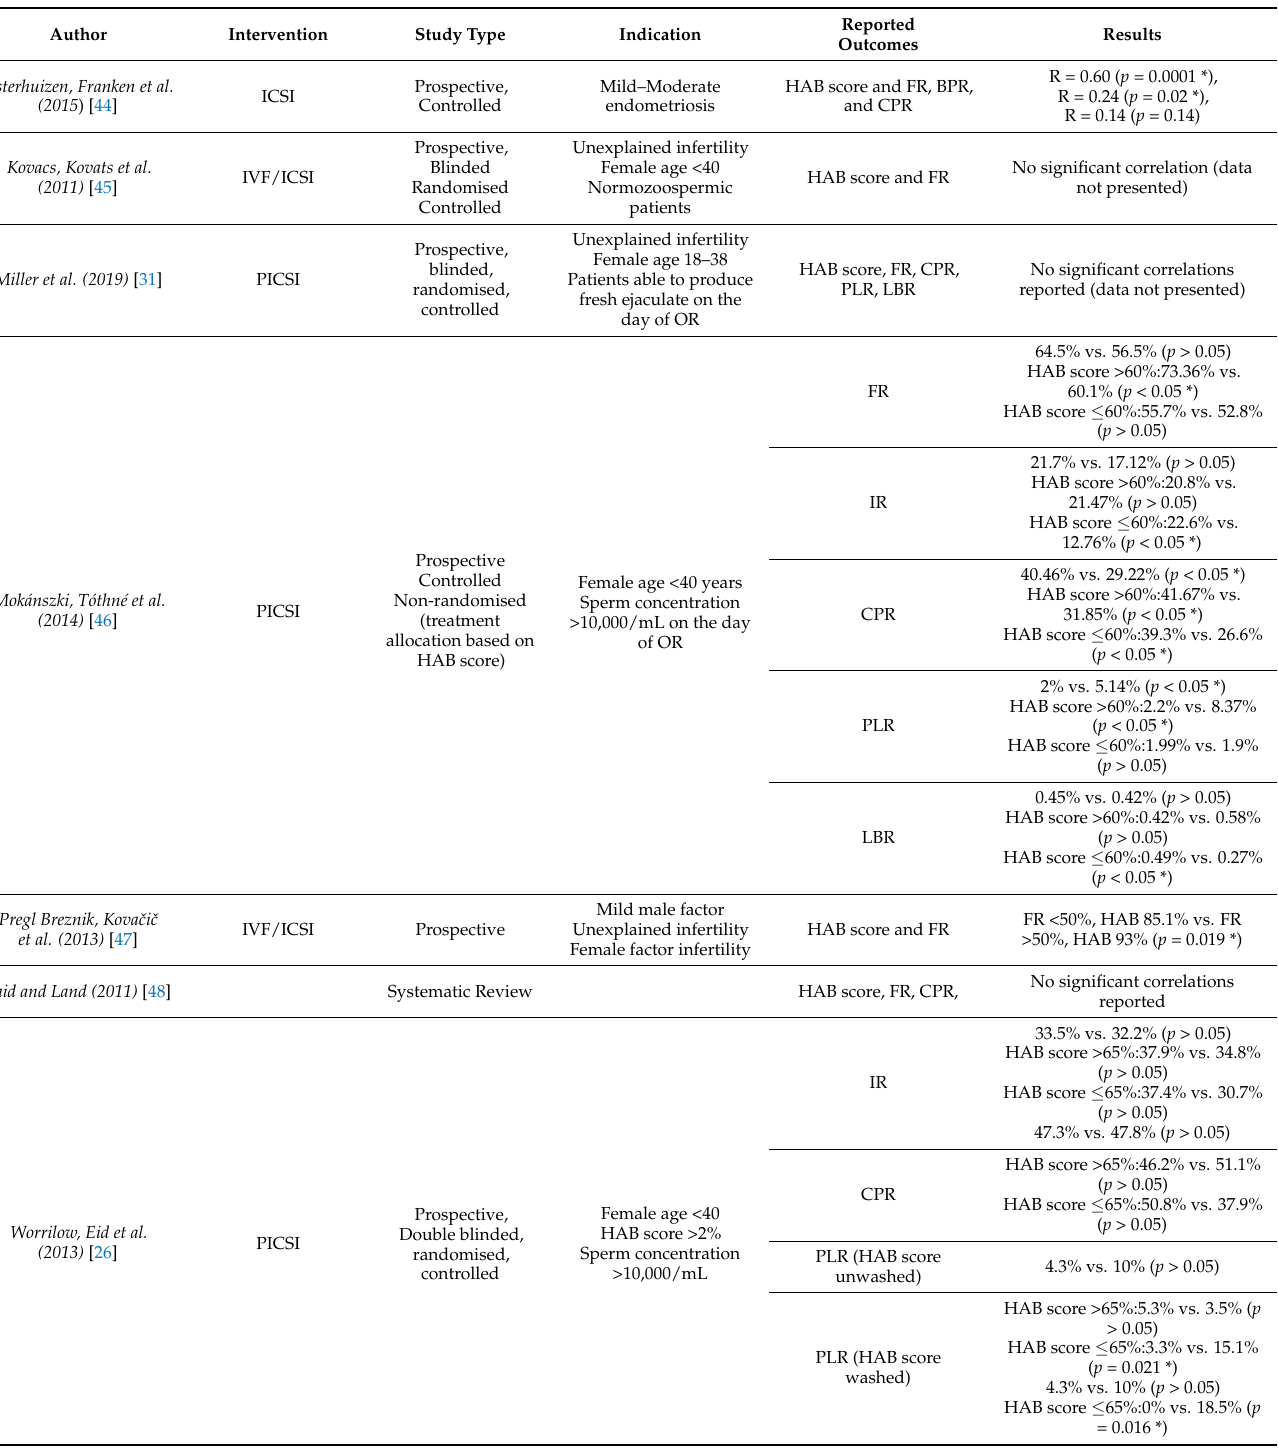
Table 1. A table summarising the studies included in this review for the assessment of the predictive value of sperm-HA binding: study question 1—Is sperm HAB score prior to insemination predictive of clinical outcomes? * Indicates a significant result ( p < 0.05). FR: fertilisation rate; CPR: clinical pregnancy rate; LBR: live birth rate; PLR: pregnancy loss rate; IR: implantation rate; BPR: biochemical pregnancy rate; IVF: in vitro